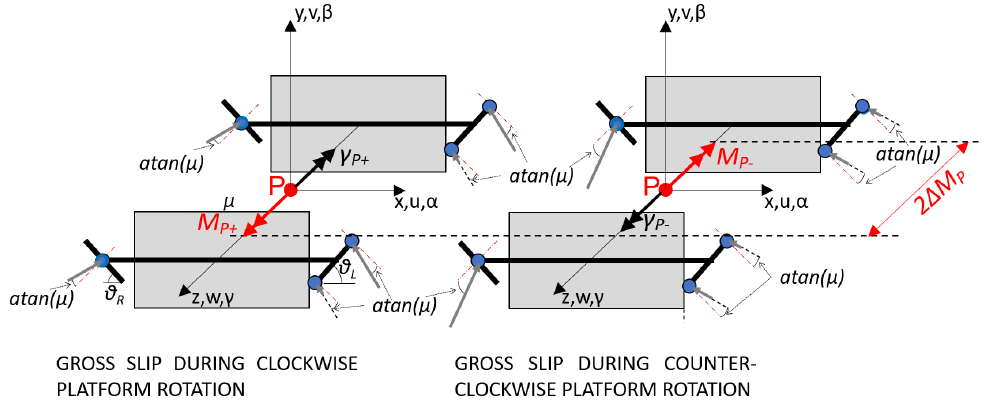
Figure 7. Representation of contact forces and their moments about platform point P for an In-Phase mode of